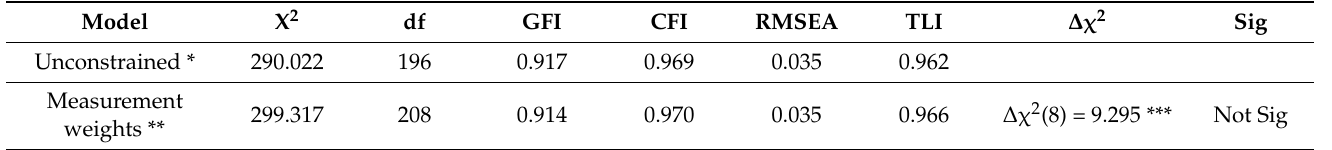
Table 5. Measurement equivalence analysis result.